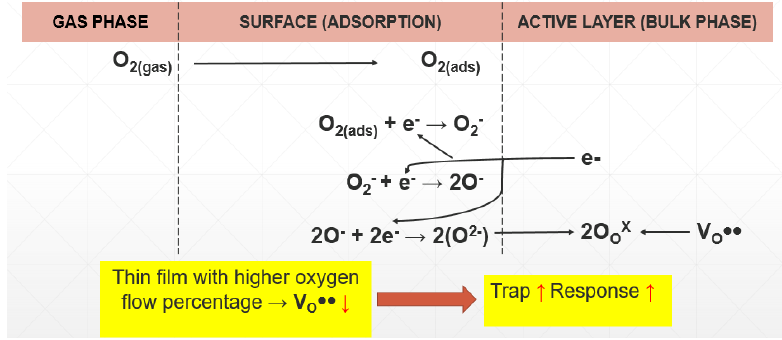
Figure 6. Response mechanisms of chemisorptive sensor.